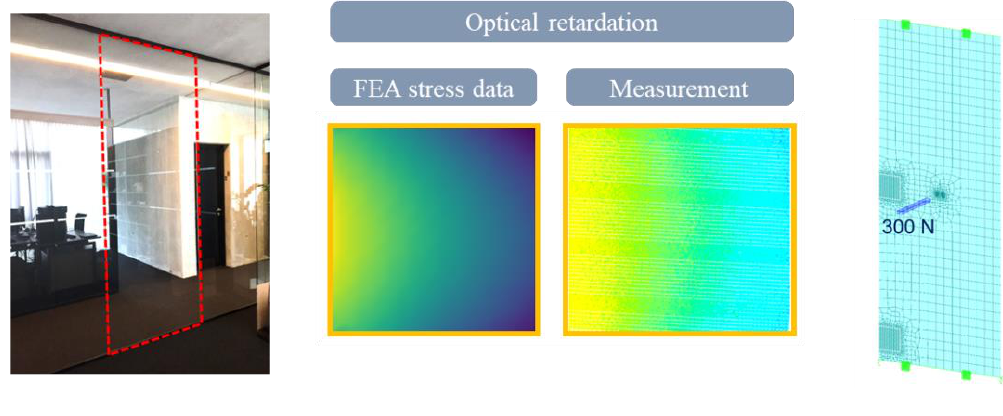
Fig. 10 Comparison between FEA simulation and in-situ measurements of a two-sided beared laminated